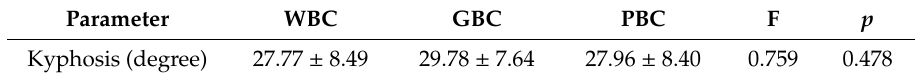
Table 2. Comparison of thoracic alignment according to backpack carriage and type.